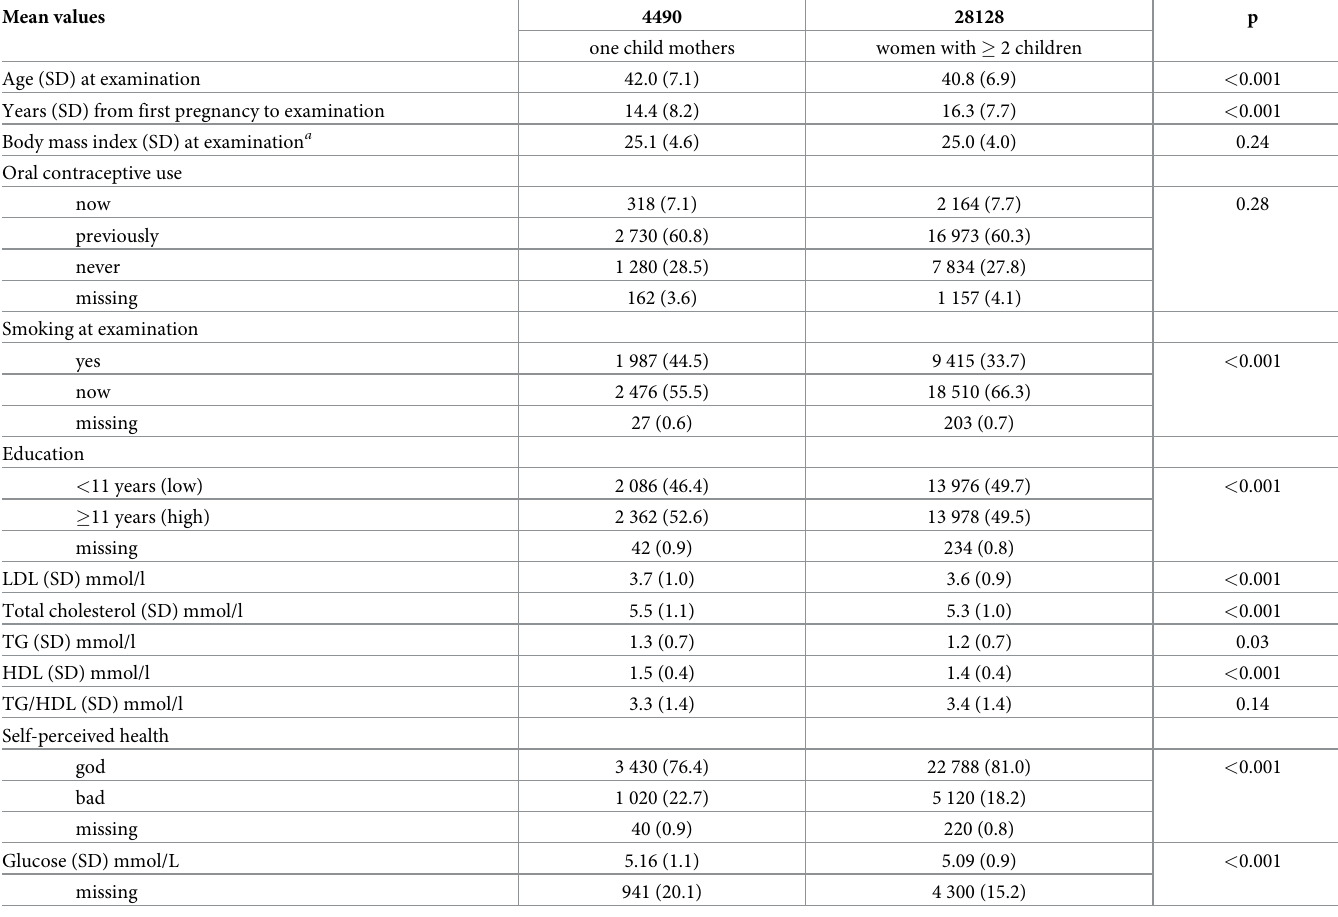
Table 1. Characteristics of 32 618 parous Norwegian women, Cohort of Norway, 1994–2003. Values are numbers (percentages) unless stated